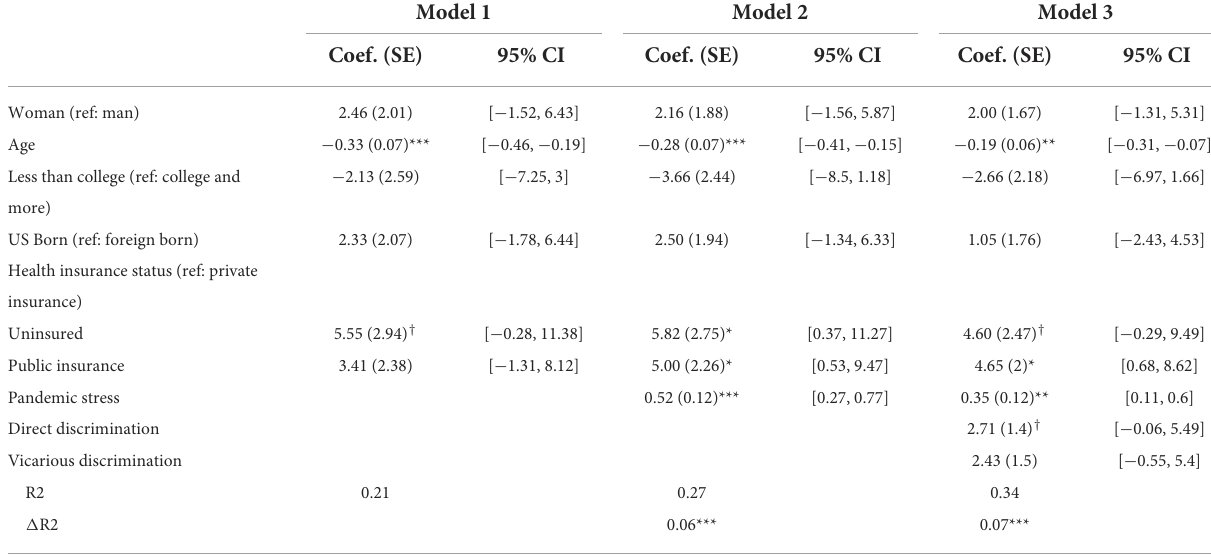
TABLE 5 Hierarchical regressions for psychological distress: South Asian. Model 1 Model 2